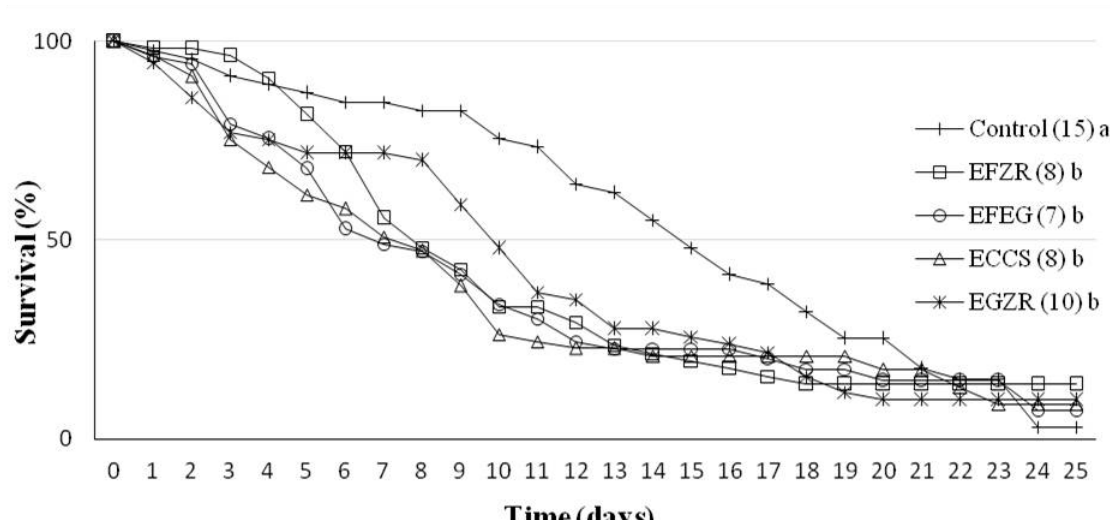
Fig 1 . Survival curves for Atta sexdens sexdens (Hymenoptera: Formicidae) workers in ingestion test with plant extracts. Average survival period (S ) is displayed besides the names of extracts, in brackets. Different lower case letters indicate difference in relation to control (data 50 obtained with the application of “log-rank”